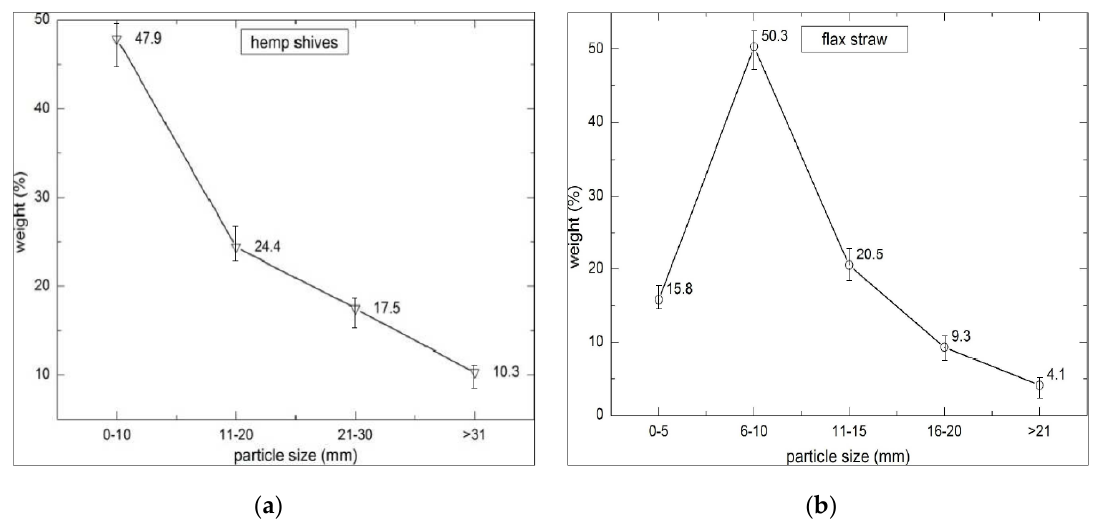
Figure 2. Fraction of: ( a ) hemp shives; and ( b ) flax straw in composites (error bars mean standard deviation of particular fraction mass).